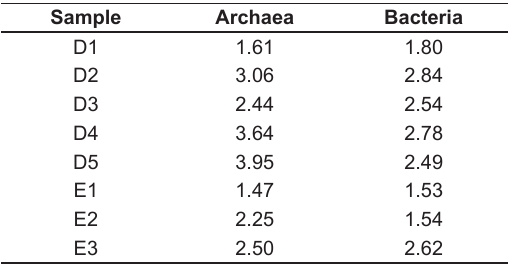
Table 3. Shannon diversity index (H) for archaea and bacteria domains along the water column, from D1 (surface.) to D5 (deep) next to Dam, from E1 (surface.) to E3 (deep) in the Entrance